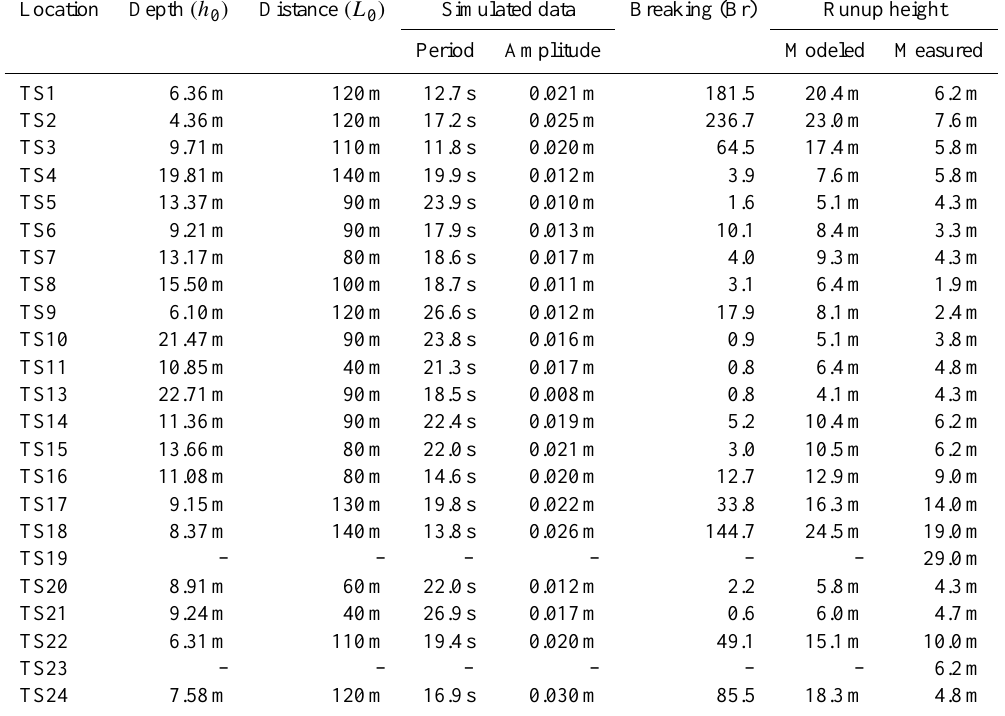
Table 1. Comparison between measured runup and simulated data.